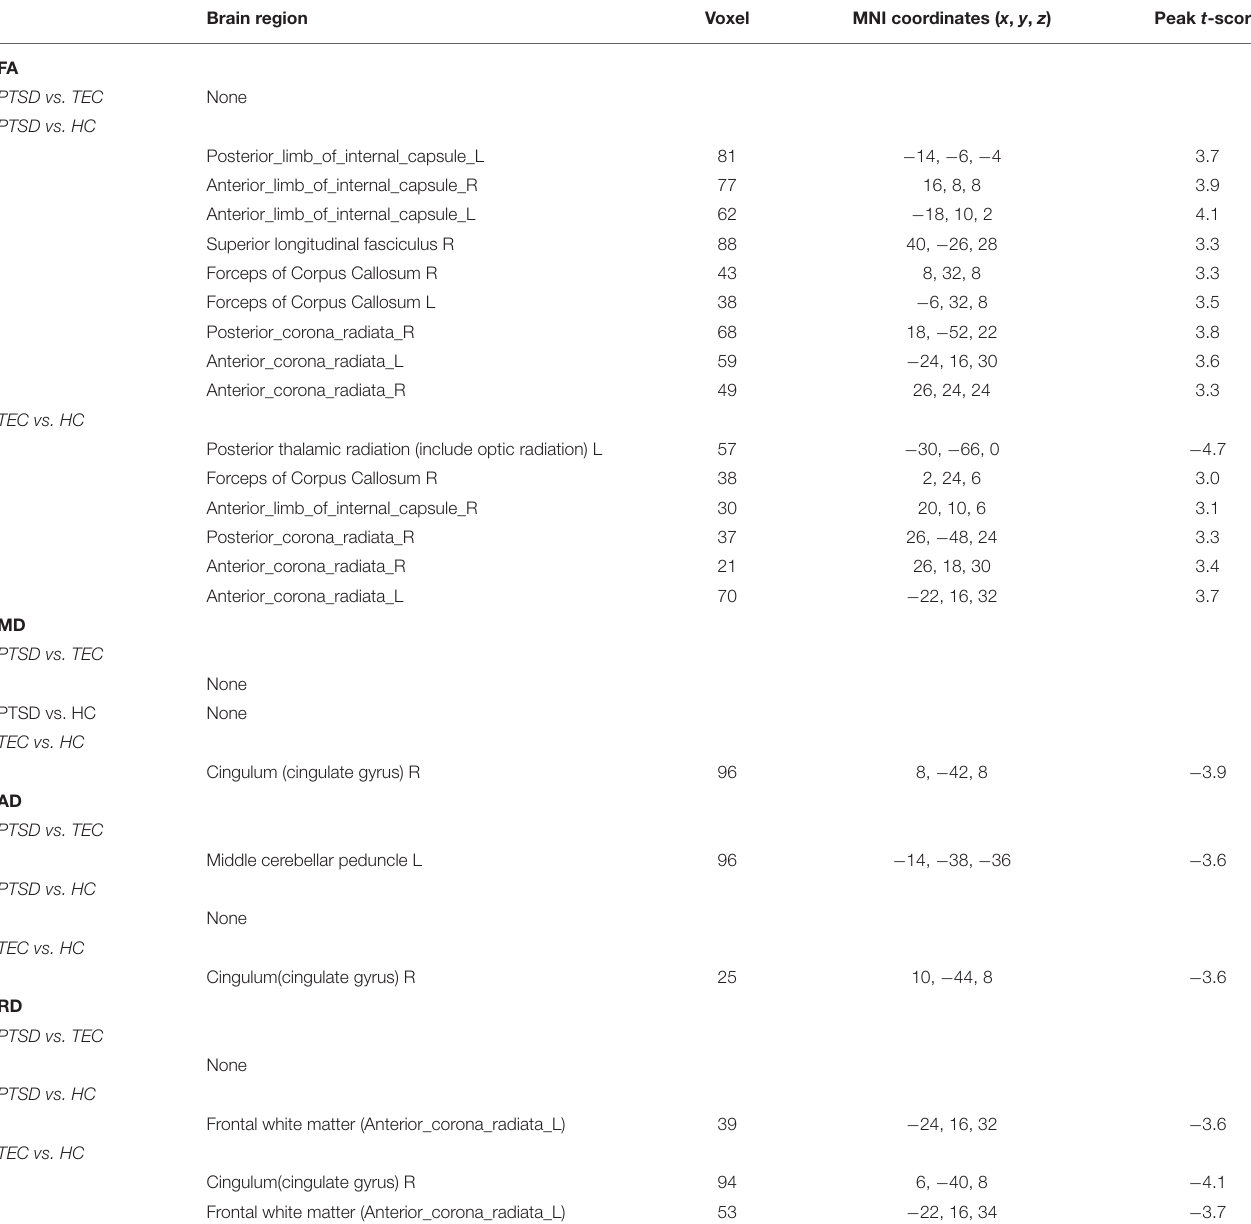
TABLE 2 | Brain regions showing white matter differences among the PTSD group, the TEC group, and the HC group. Brain region Voxel MNI coordinates ( x , y , z ) Peak t